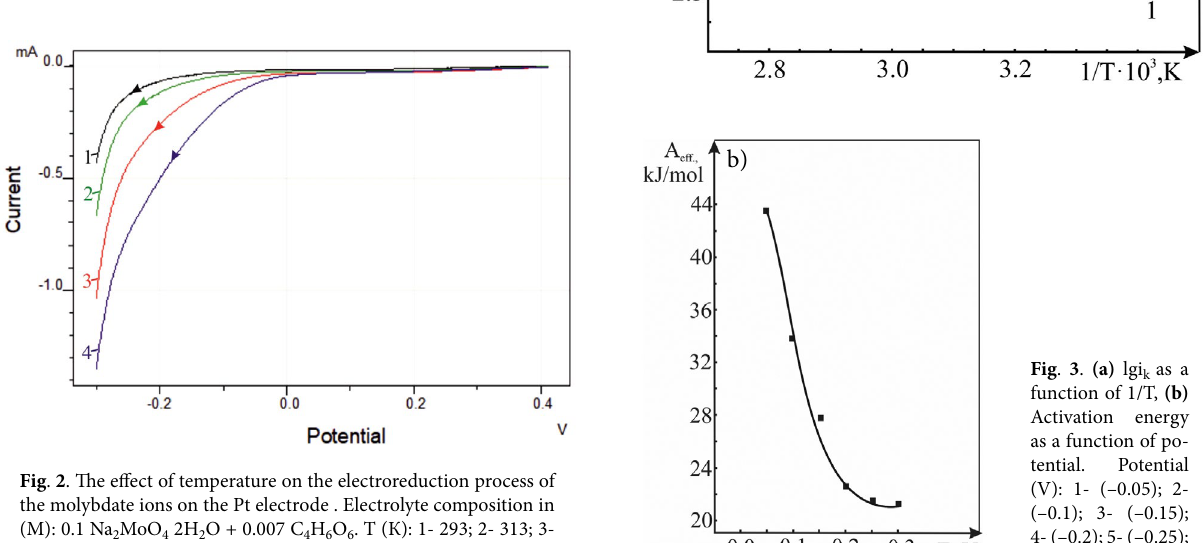
Fig . 2 . The effect of temperature on the electroreduction process of the molybdate ions on the Pt electrode . Electrolyte composition in (М): 0.1 Na 2 MoO 4 2H 2 O + 0.007 C 4 H 6 O 6 . Т (К): 1- 293; 2- 313; 3- 333; 4- 353. At a scan rate of Е V = 0.02 V/s